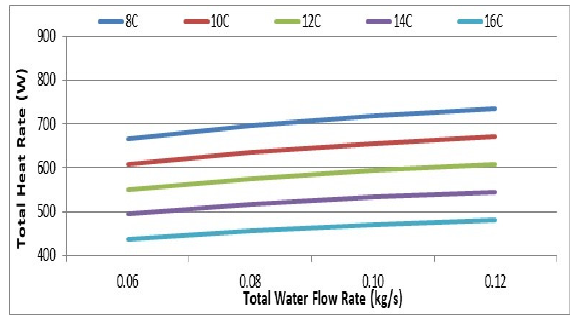
Fig. 13. The total heat rate of terminal units at 8, 10, 12, 14 and 16 °C water supply temperature and valve opening: Valve 1=100%, Valve 2=100% and Valve 3=50%.